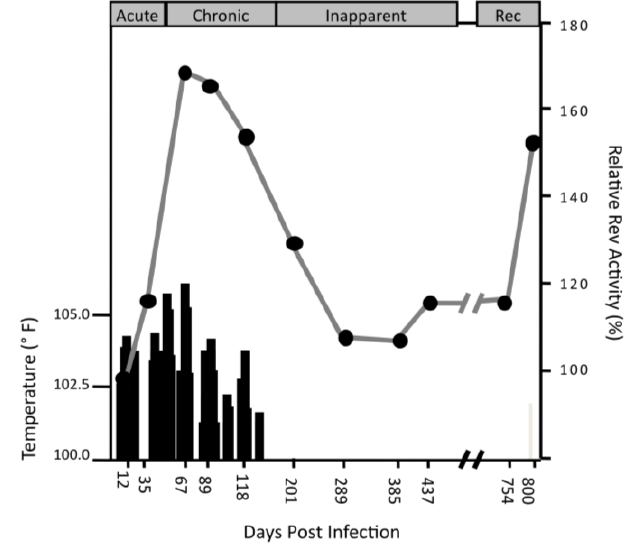
Figure 2. Changes in Rev activity during progression of clinical disease [8]. In vitro biological activity of Rev variants from pony 524 was quantified in transient transfection assays using 293T cells as previously described [3]. Briefly, Rev variant cDNAs were co-transfected with a chloramphenicol acetyltransferase (CAT) reporter plasmid (pERRE- All) in HEK293T cells and CAT activity was quantified as percent acetylation. The results are presented as a percentage of activity compared to R1, the founder variant in the inoculum. The overall Rev activity for each time point was calculated as the average Rev activity of tested variants, weighted by the frequency of the tested variant in the sampled population. Solid bars indicate the rectal temperature of pony 524. The clinical stages of disease are indicated as: Acute, Chronic, Inapparent, and Rec